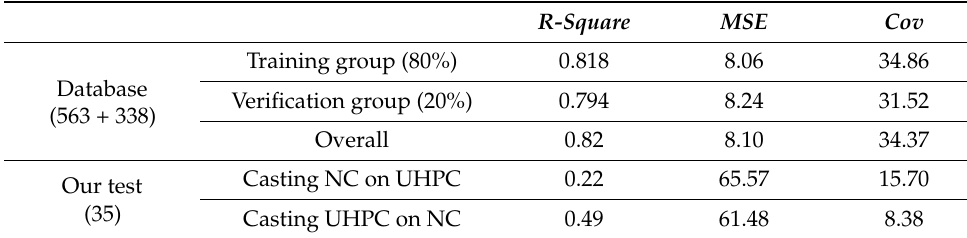
Table 5. Statistical analysis